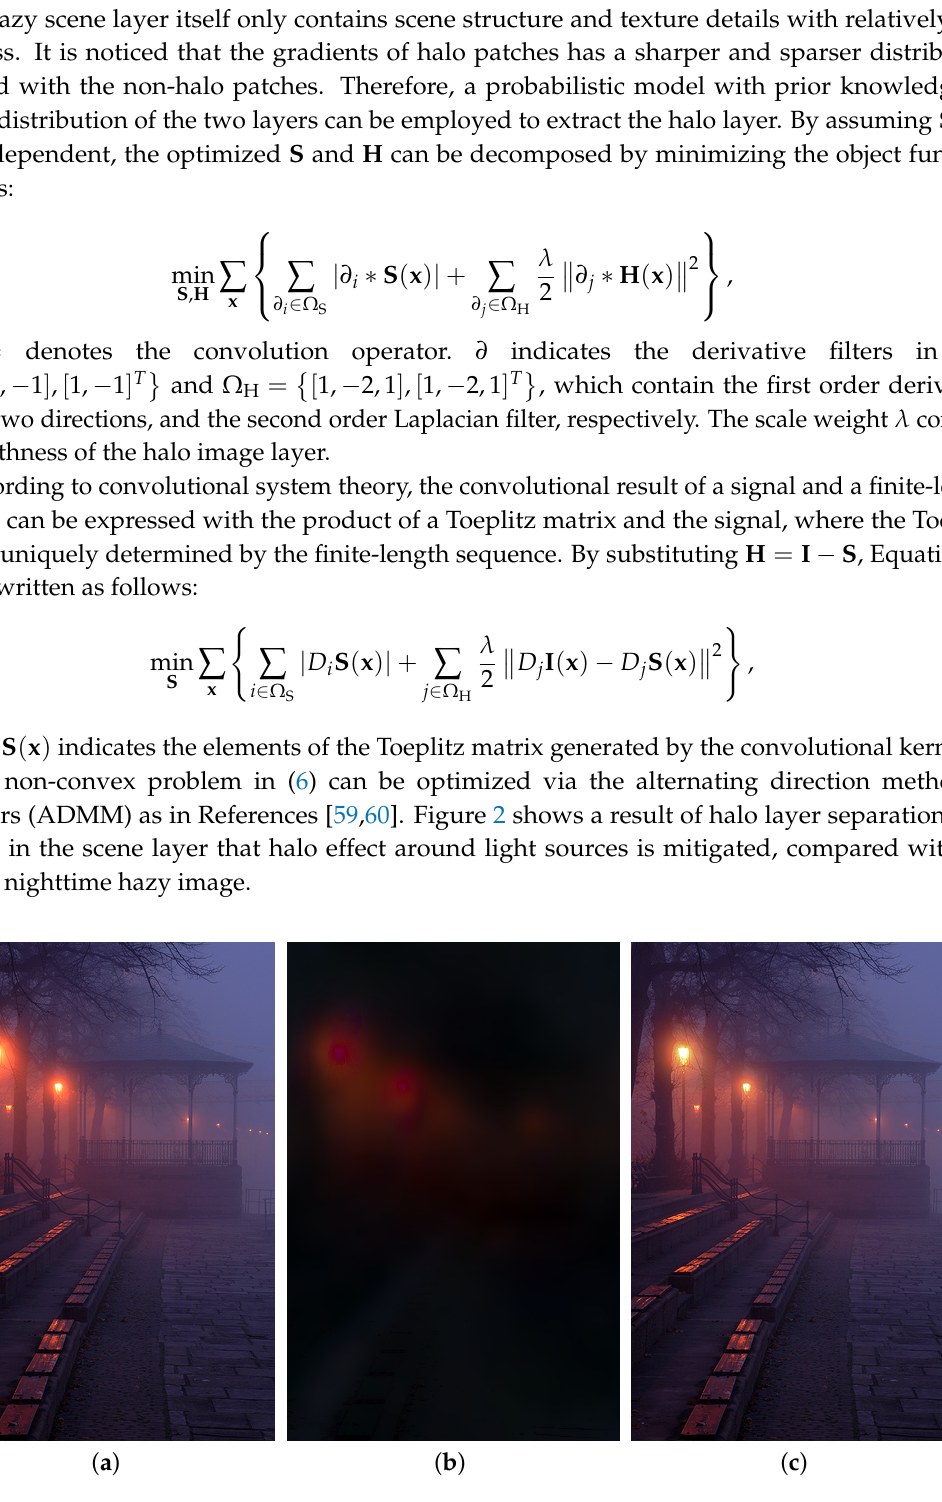
Figure 2. Illustration of halo layer extraction. ( a ): a nighttime hazy image, ( b ): the halo layer, ( c ): the scene